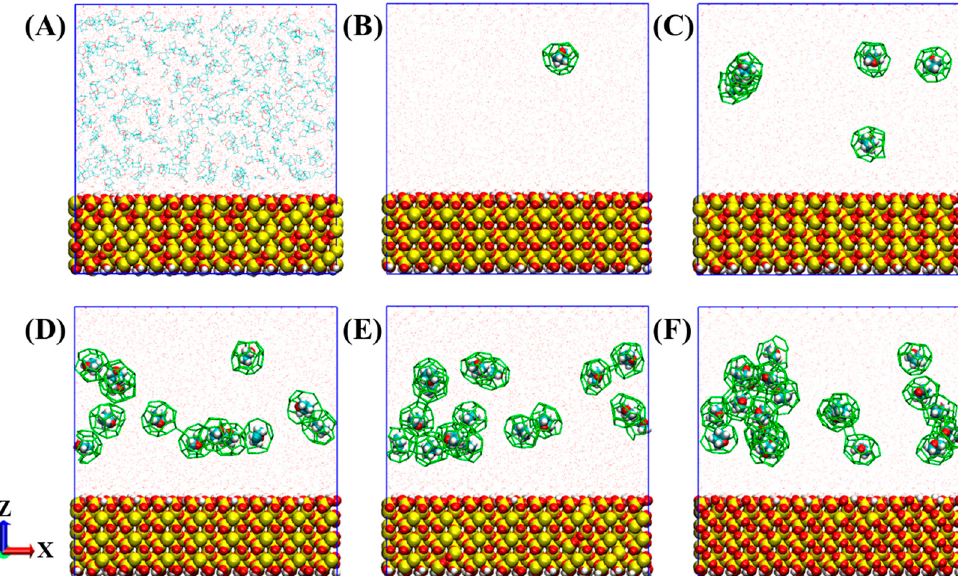
Figure 2. Formation process of hydrates in the system without nitrogen bubbles: ( A ) 0 ns, ( B ) 100 ns, ( C ) 200 ns, ( D ) 400 ns, ( E ) 800 ns, and ( F ) 2000 ns. THFs not in hydrate cages are not represented in ( B – F ) for simplicity. Atoms are shown as Figure 1, and THF-filled cages are represented as green stick lines.